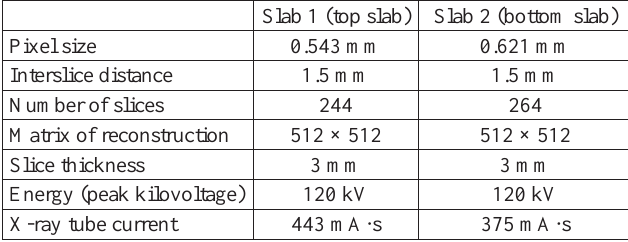
Table 1. Analytical conditions of the CT-scan